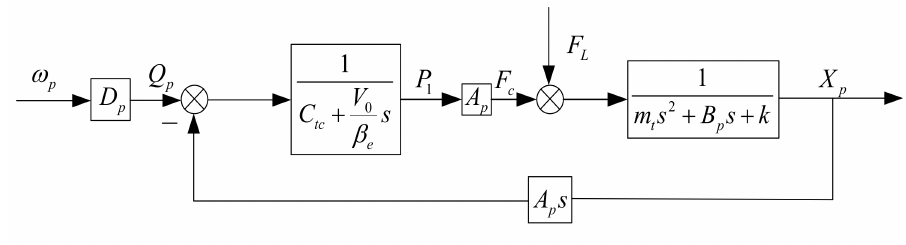
Figure 4. Pump-controlled cylinder transfer block diagram.